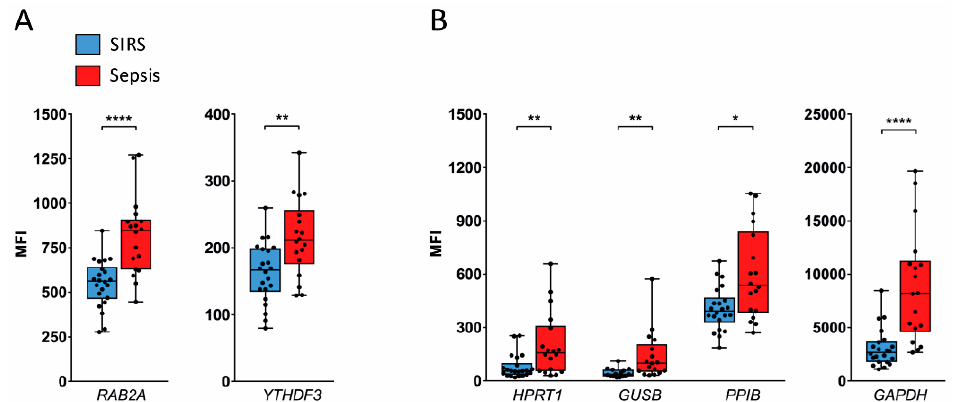
Figure 5. Comparison of candidate reference gene expression in granulocytes from the validation set by QGP. Results for two detectable candidate reference genes identified from microarray ( A ) and four additional known reference genes ( B ) are grouped by similar signal intensity (MFI) ranges. Data are represented as blue (SIRS, n = 22) and red (sepsis, n = 18) box plots with whiskers from minimum to maximum, median, and dispersion plots. As an exception, only 15 samples from patients with SIRS and 17 with sepsis were available for GUSB . * p < 0.05, ** p < 0.01, **** p < 0.0001 from the Wilcoxon rank-sum test.